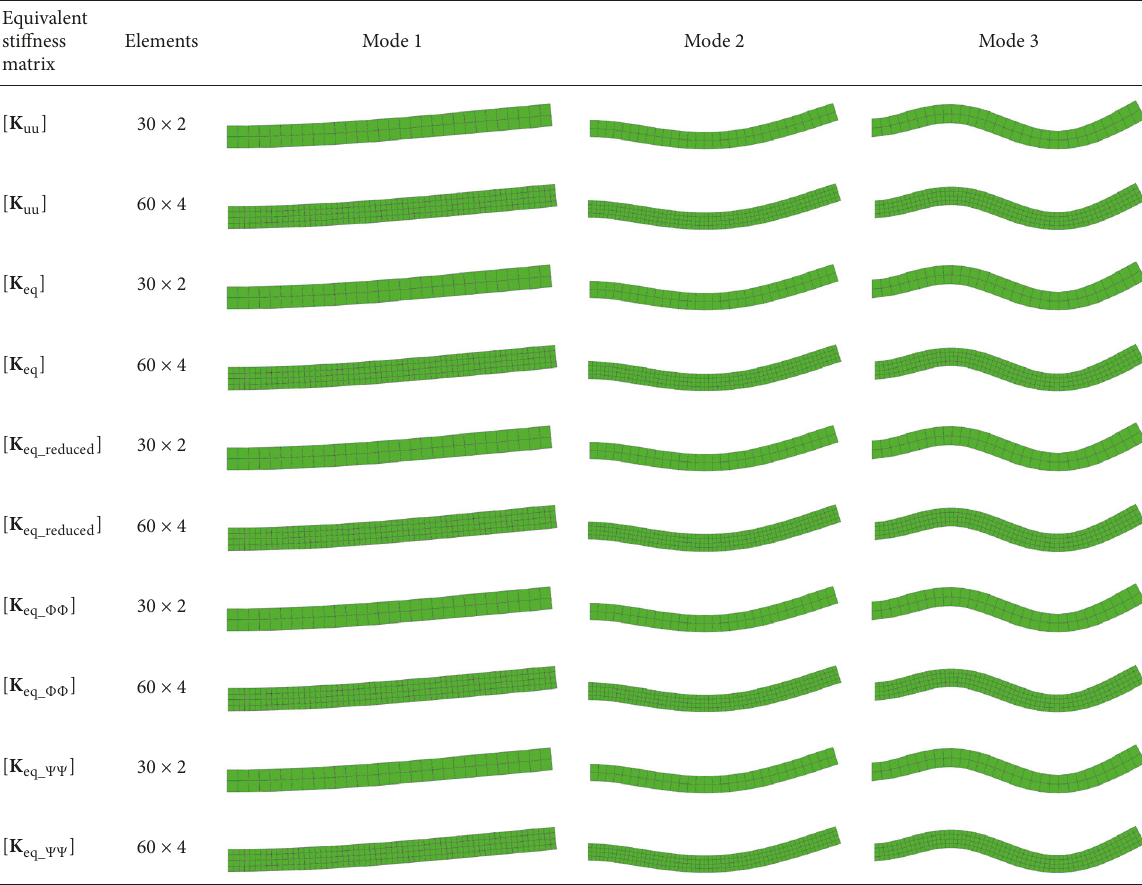
Figure 7: The first- to third-order modes of clamp-free BaTiO 3 –CoFe 2 O 4 FGMEE beams using different elements with exponential factor 𝜂 = 5.0 by ICS-FEM.